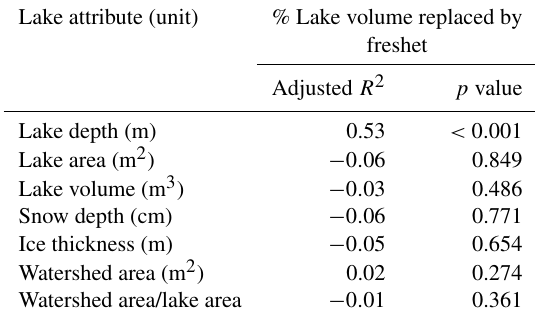
Table 3. Results for a linear regression between total lake water replacement with multiple lake and watershed properties. The ad- justed R 2 and p values are shown for each isotope. Linear regres- sions were performed using the “lm” function using R 4.0.2 (R Core Team,